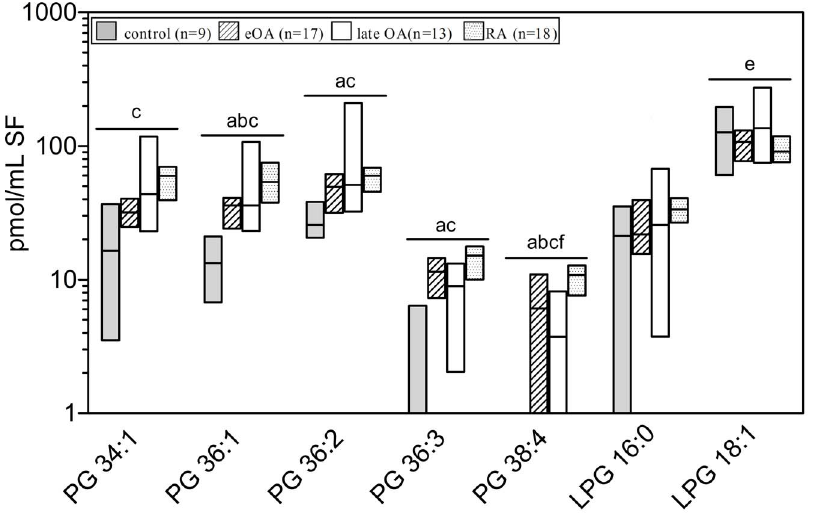
Figure 6. Concentrations of phosphatidylglycerol (PG) and lysophosphatidylglycerol (LPG) species in human knee synovial fluid. Synovial fluid was obtained from donors serving as controls and from patients with early osteoarthritis (eOA), late OA (lOA), and rheumatoid arthritis (RA). PG and LPG species were determined by liquid chromatography coupled with tandem mass spectrometry as outlined in Material and Methods . Species annotation is based on the notion that only ester bonds are present. Values are presented as median and interquartile range. Significance was considered in the following way: a: p # 0.05: control vs eOA; b: p # 0.05: control vs lOA; c: p # 0.05: control vs RA; d: p # 0.05: eOA vs lOA; e: p # 0.05: eOA vs RA; and f: p # 0.05: lOA vs RA. PG- phosphatidylglycerol, LPG-